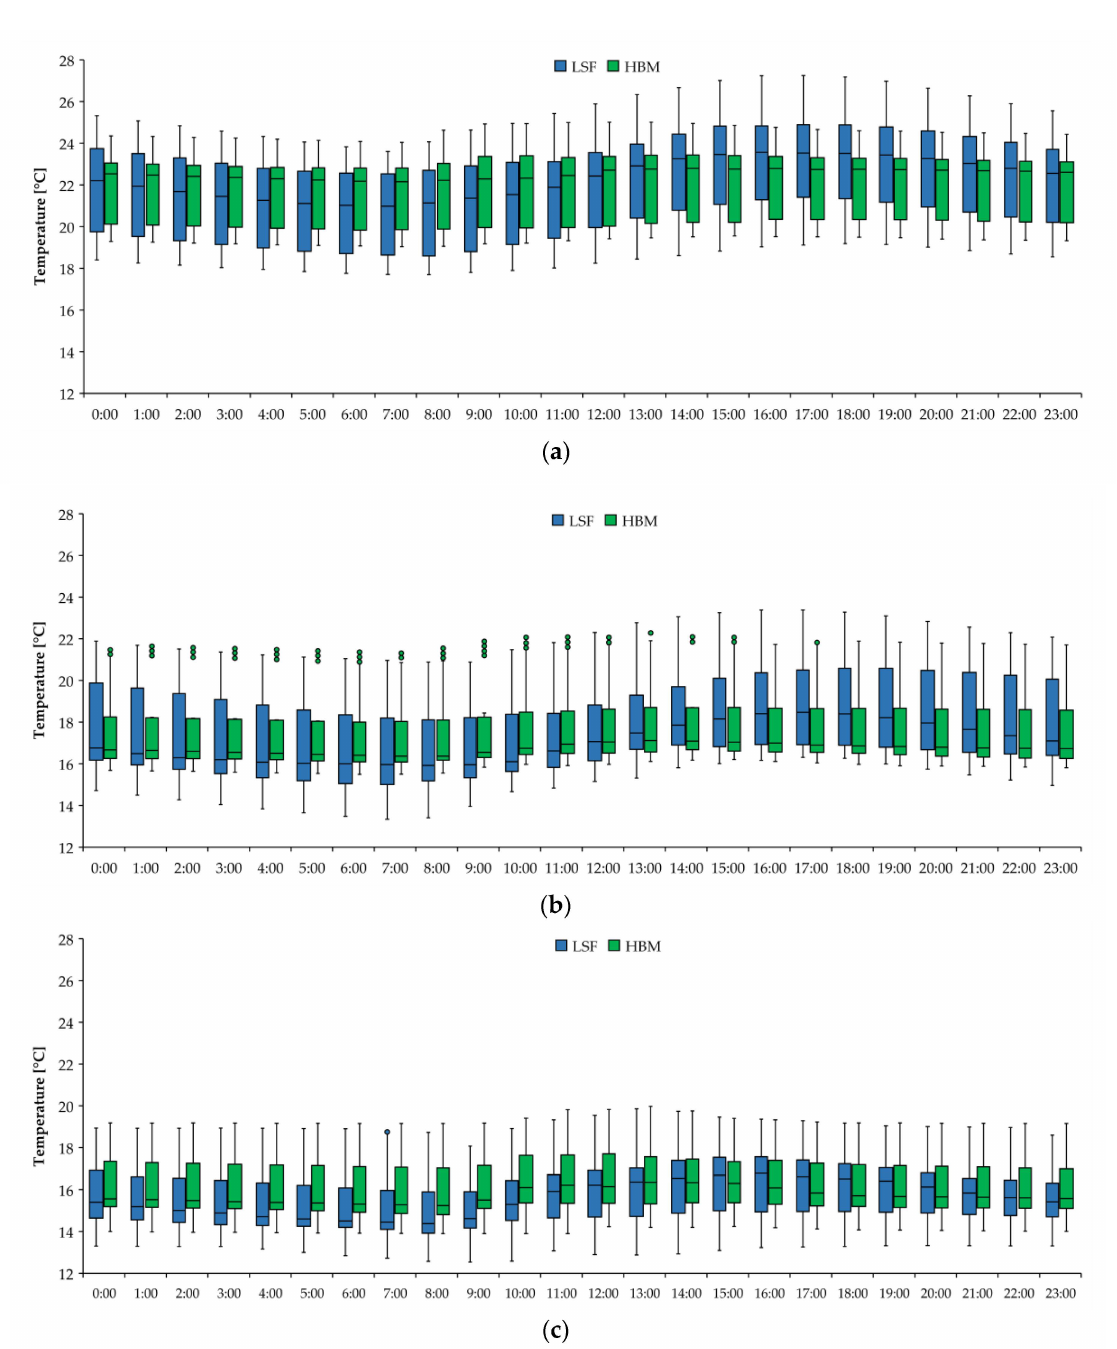
Figure 9. Hourly box plot representation of the indoor air temperatures: ( a ) summer; ( b ) shoulder season; ( c ) winter. Maximum indoor air temperature values of 23.38 ◦ C and 21.90 ◦ C were measured for the LSF and HBM test cells during the shoulder season months, respectively. In terms of the minimum indoor air temperatures, values of 13.34 ◦ C for the LSF test cell and 15.50 ◦ C for the HBM test cell were measured; thus, over the analysed shoulder season period, the indoor air temperatures in the LSF test cell varied within a range of 10.04 ◦ C, while in the HBM test cell the indoor air temperatures varied within a range of 6.40 ◦ C